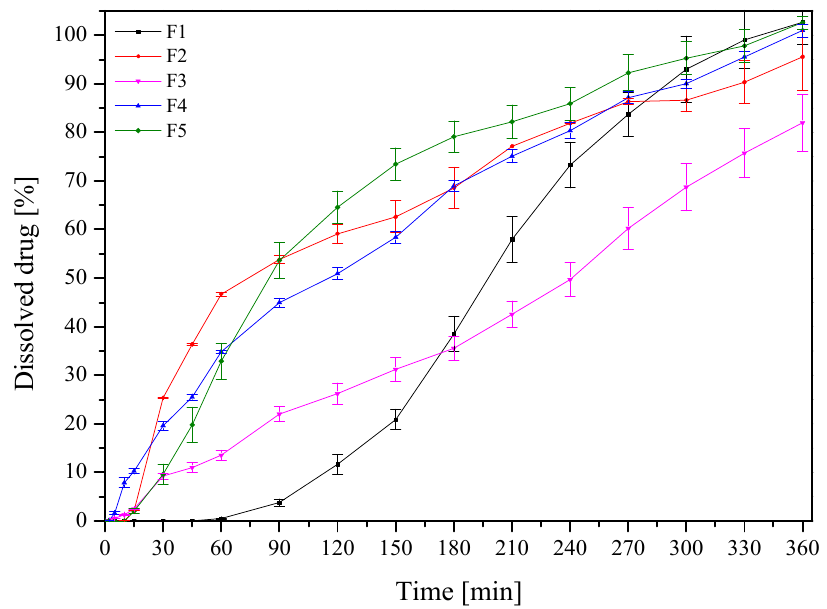
Figure 7. Dissolution profiles of the RSV/CD tablets (F1–F5) with the compression pressure 150 MPa. 544 To investigate the mechanism responsible for the resveratrol sustained release from 545 tablets, the release data obtained for the formulation F1–F5 were fitted to the following dissolution models:zero-order, first-order equations, Higuchi model (used for the matrix systems), and the Korsmeyer-Peppas model (used for the swellable matrices) (Supplemen- tary materials, Table